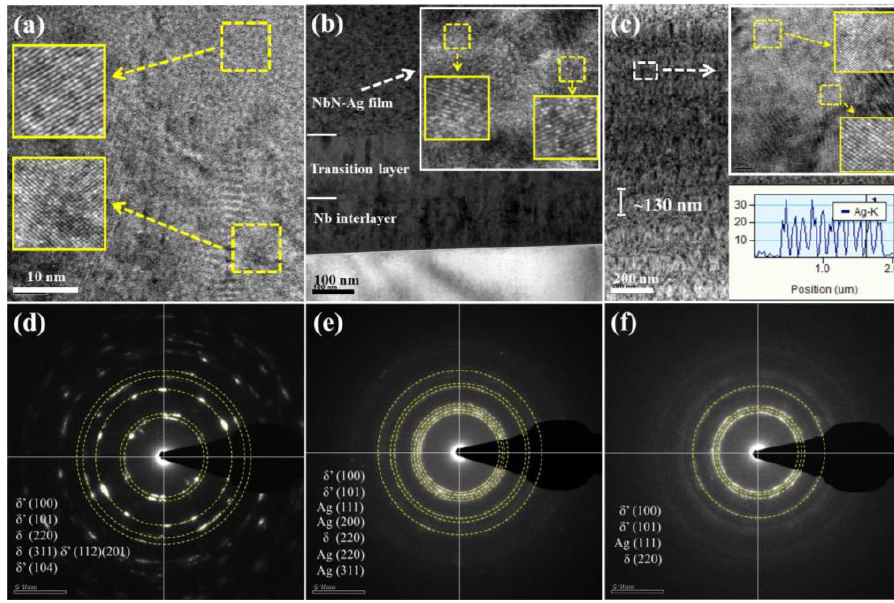
Figure 3. HRTEM cross-sectional micrographs and the corresponding SAED patterns of the films: ( a , d ) NbN; ( b , e ) NbN-Ag; ( c , f )